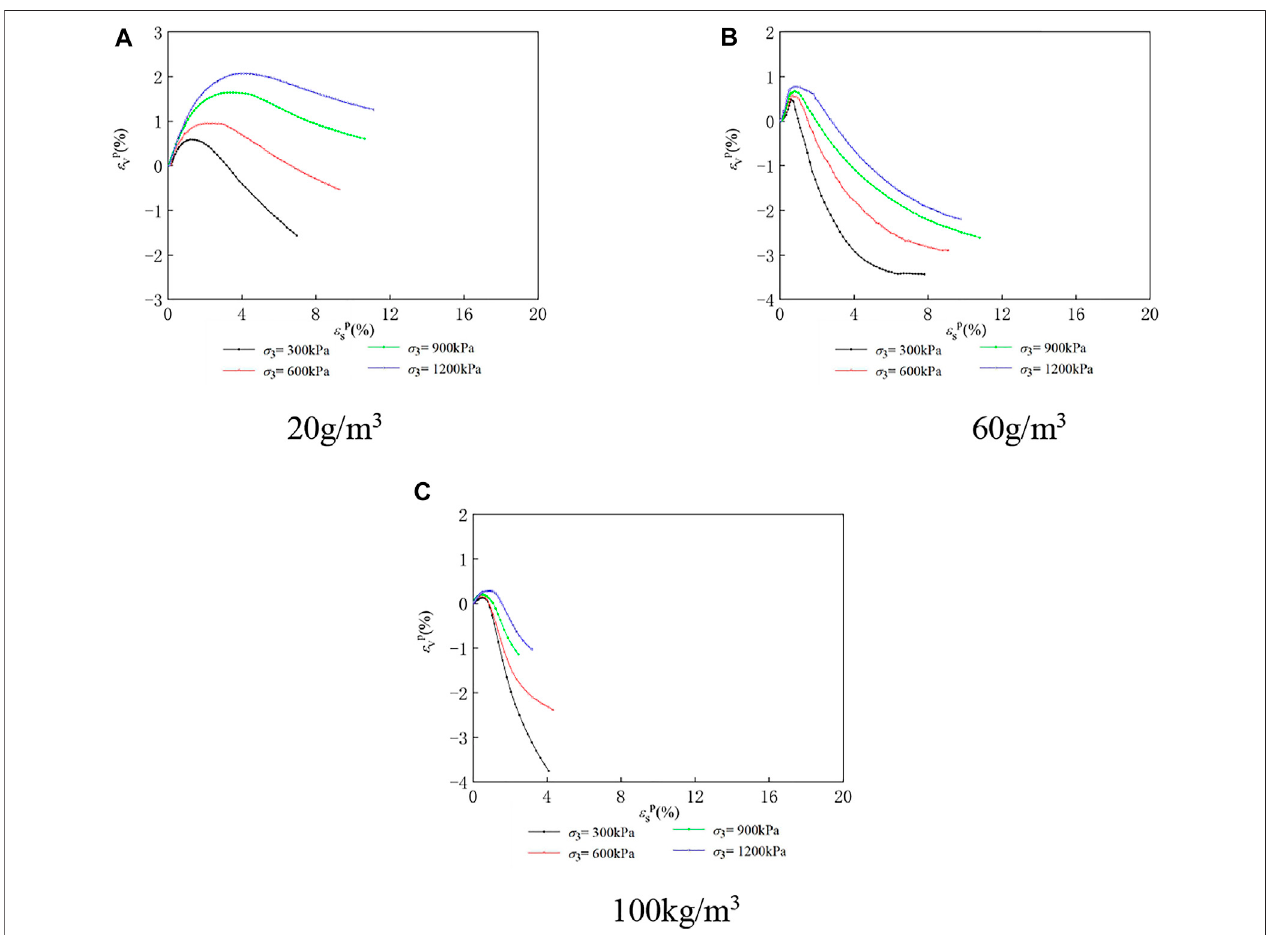
FIGURE 10 | The plastic volumetric strain and shear strain of LCSG material. (A) 20 g/m3 (B) 60 g/m3 (C) 100 g/m 3 .